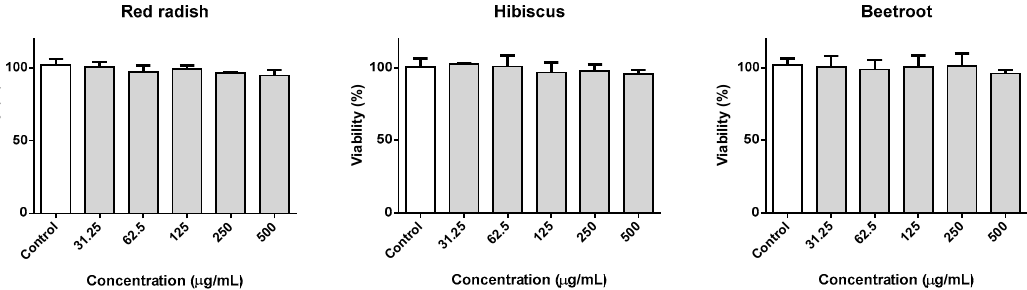
Figure 4. Viability of AGS cells exposed to red radish, hibiscus, and red beetroot extracts for 24 h, in the 31.25–500 µg/mL range.